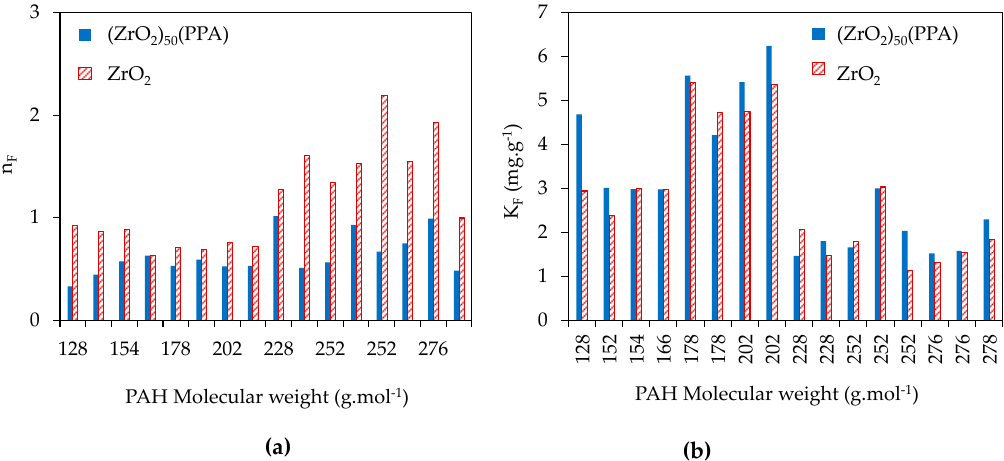
Figure 6. Variation of Freundlich parameters: ( a ) nF and ( b ) KF as a function of molecular weight of the 16 PAH molecules.